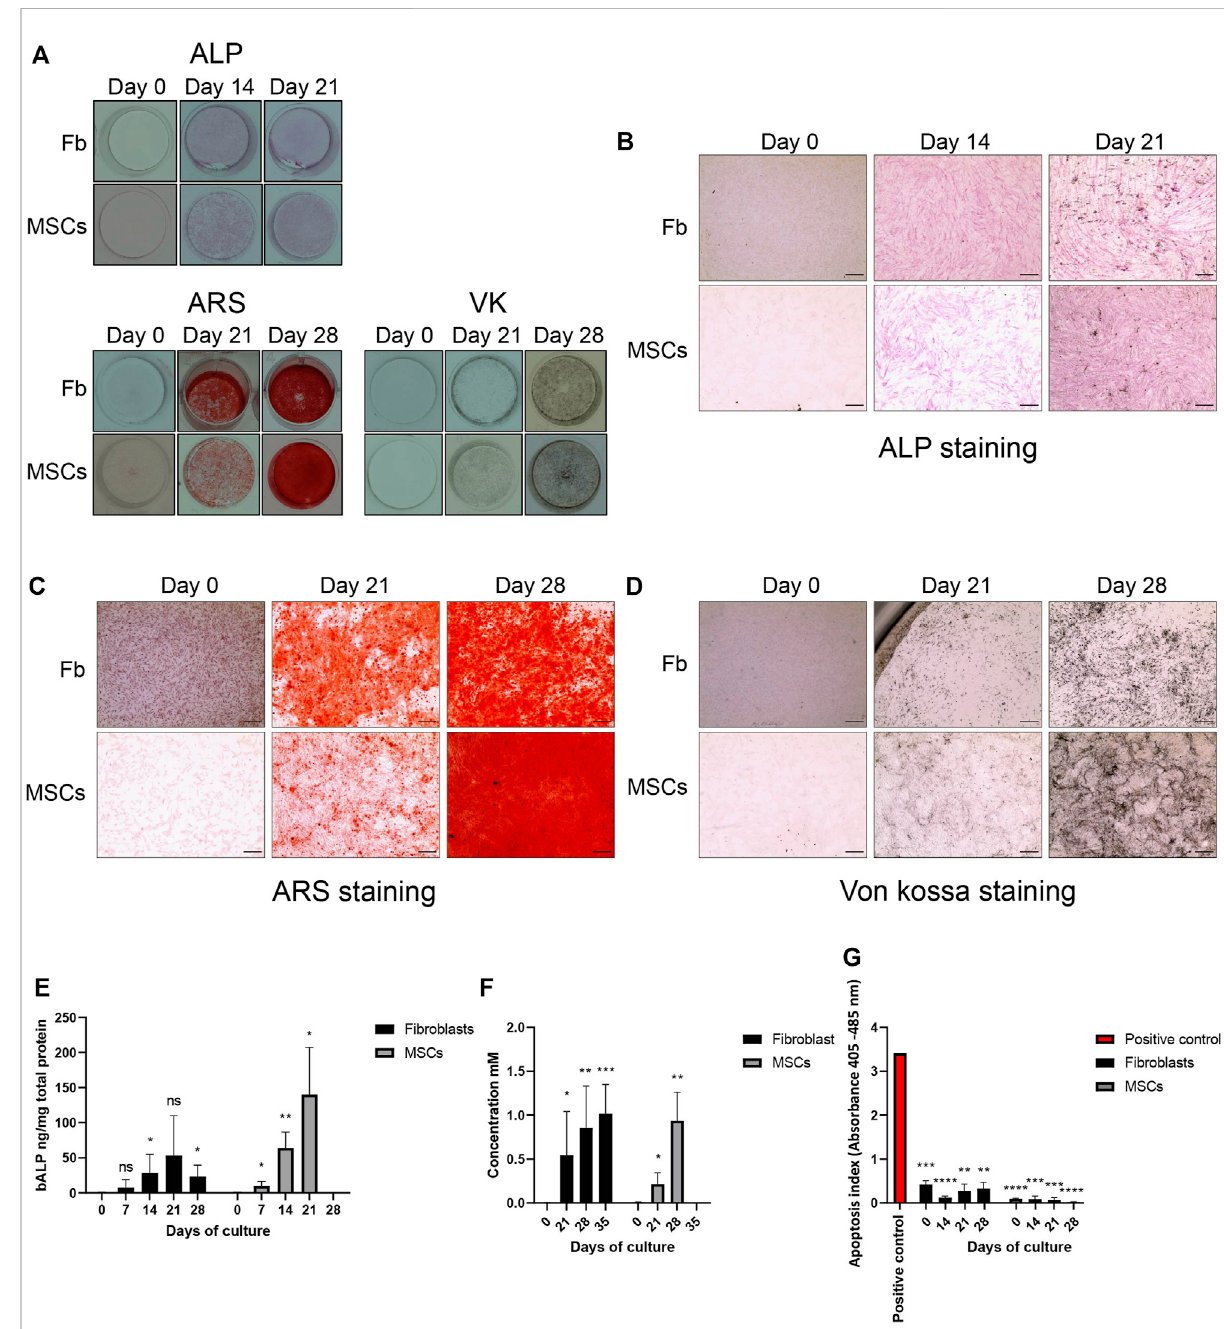
FIGURE 2 Osteoblastic differentiation. Osteoblastic differentiation of fi broblasts (Fb) and MSCs demonstrated by alkaline phosphatase (ALP, preosteoblastic marker) detection and mineralization staining (Von Kossa, VK), Alizarin Red, ARS). (A) An overview of ALP, ARS and VK staining in undifferentiatedcells(0days)andthroughouttheosteoblasticdifferentiationtreatment(Day14,21and28).Imagesweretakenbyasingle lensre fl ex camera. (B) ALP detection at 0 days, 14 days and 21 days. Stained ALP appears in pink. Light microscope, 500 nm scale bar. (C,D) Detection of mineraldepositsat0,21,and28 days.CalciumdepositsstainredwithARSwhilepotassiumstainsblackwithVK.Lightmicroscope,500 nmscalebar. (E) Quanti fi edboneALP(bALP)in fi broblastsandMSCsat0,7,14,21and,28 daysand0,7,14and,21 days,respectively. Signi fi cantly higherbALPcan bedetectedintreated fi broblastsat14(* p =0.0388)and28(* p =0.0146)dayscomparedtoundifferentiated fi broblasts.InMSCs,higherbALPcanbe detected in treated MSCs at 7 (* p = 0.0372), 14 (** p = 0.0040) and 21 (* p = 0.0111) days compared to undifferentiated MSCs. bALP is normalized to total protein content. Mean ± standard deviation (SD). (F) Quanti fi cation of ARS staining in fi broblasts and MSCs at 0, 21, 28 and 35 days and at 0, 21 and 28 days, respectively. Signi fi cantly higher ARS concentration can be detected in fi broblasts treated until 21 (* p = 0.0364), 28 (** p = 0.0057) and 35 (*** p = 0.0004) days compared to undifferentiated fi broblasts. Findings were similar in MSCs. Signi fi cantly higher ARS concentrations